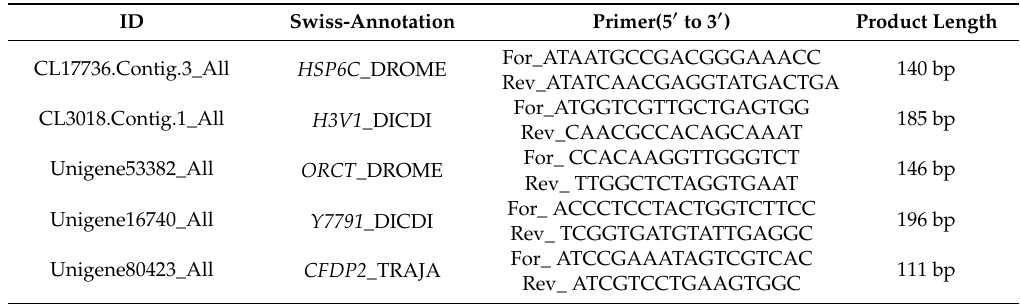
Table 1. Primer sequences of the five target unigenes, or contigs, analysed using qRT-PCR.